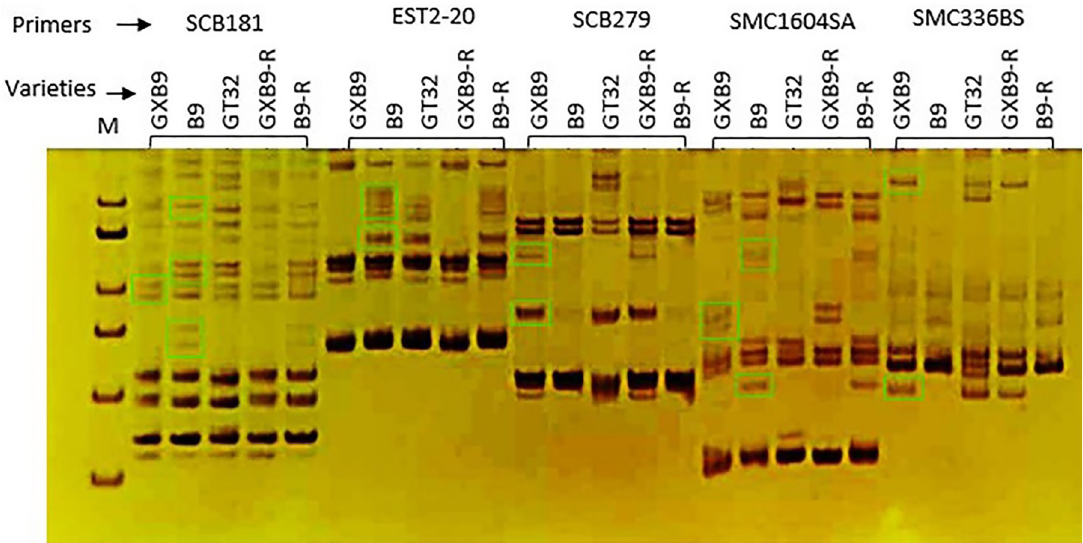
Fig 12. SSR band profiles for three different sugarcane clones analyzed by PAGE. From left to right, every five lanes corresponded to one primer and five templates. The template sequences were GXB9 plant cane (GXB9), B9 plant cane (B9), GT32 plant cane (GT32), GXB9 ratoon cane (GXB9-R), B9 ratoon cane (B9-R) while the primers were SCB181, EST2-20, SCB279, SMC1604, SMC336BS, respectively. M, molecular marker.